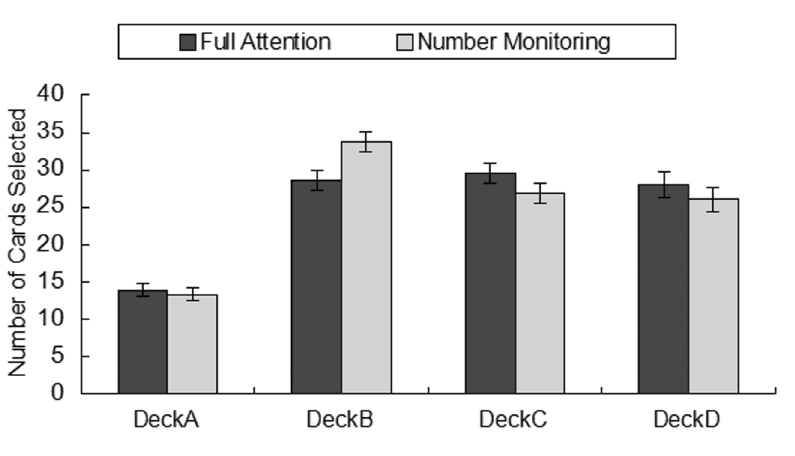
Figure 2. Draws by